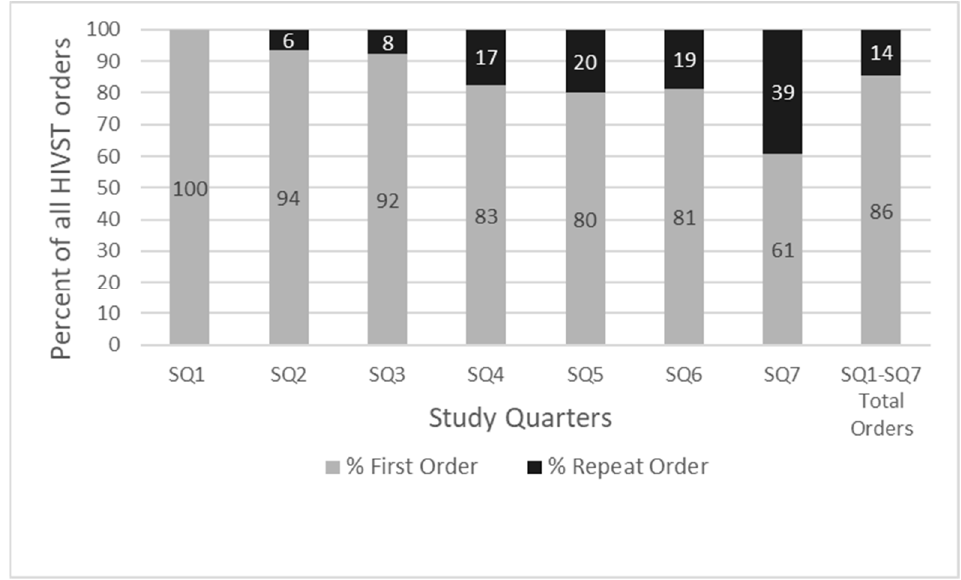
Figure 2. Percentages of first and repeat orders of HIVST kits ordered, by study quarter (SQ).